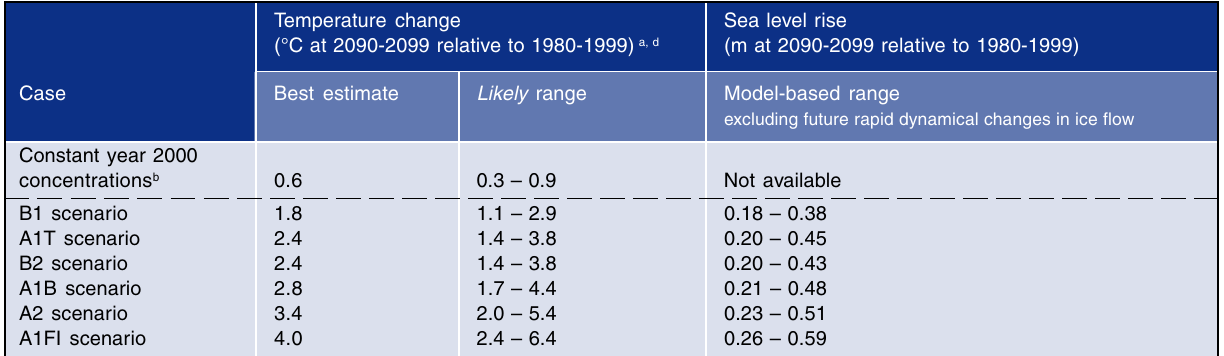
Table SPM.1. Projected global average surface warming and sea level rise at the end of the 21 st century. {Table